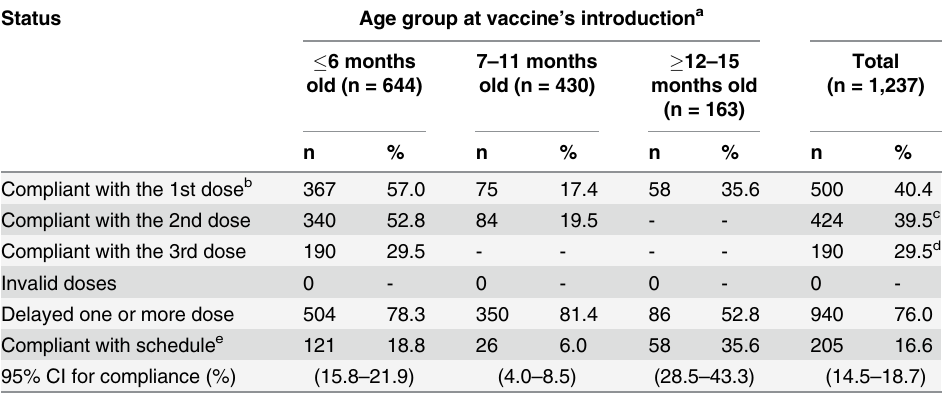
Table 3. Compliance with PCV10 recommended schedules by dose and age groups, 6 to 8 months after its introduction.